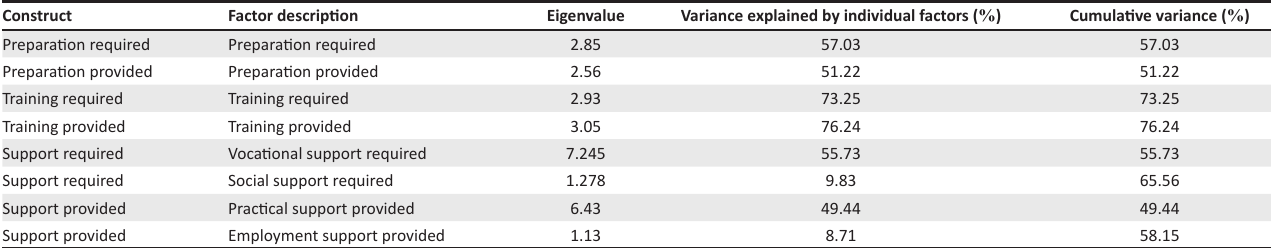
TABLE 2: Combined results of the exploratory factor analysis. Construct Factor description